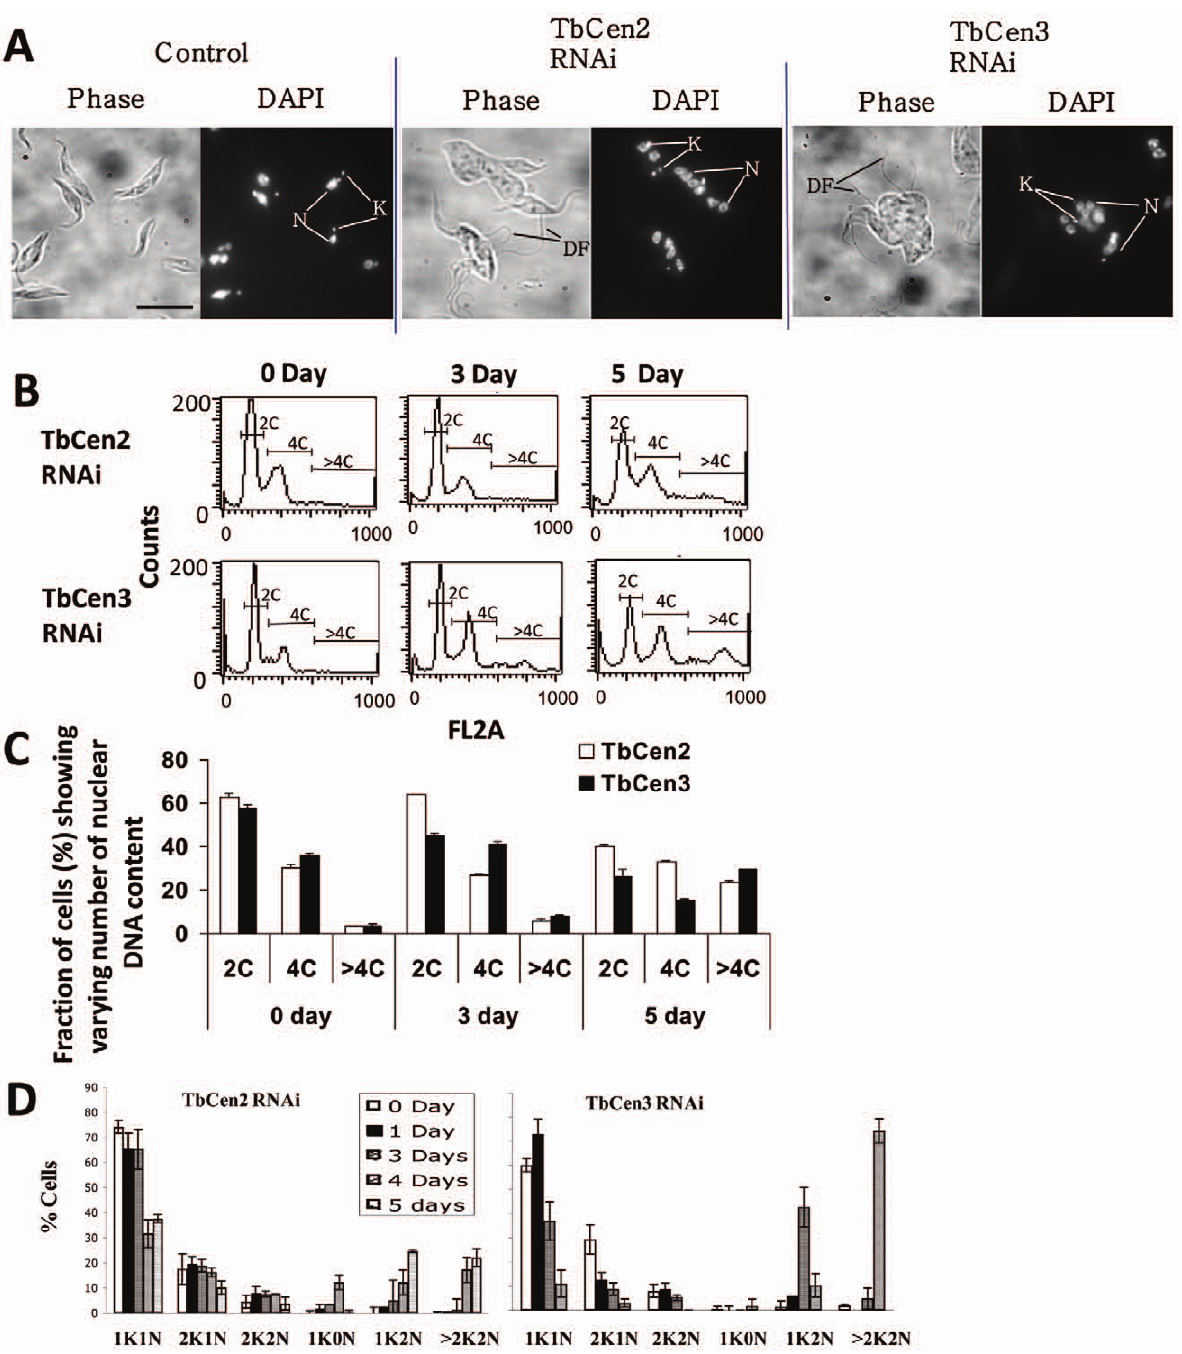
Figure 2. Analysis of cell structure and kinetoplasts and nuclei number in the RNAi cells. A : DAPI-stained images of the control and TbCen2 and 3-depleted cells, 4d after RNAi induction. DF, detached flagella; K, kinetoplast; N, nucleus. Scale bar, 5 m m. ( B & C ) Fluorescence-activated cell sorting analysis for relative DNA content of TbCen2 and 3 depleted cells. B : Histogram plots of cell count by DNA content obtained directly from the flow cytometry analysis are shown. C : The percentage of cells that contain two times the DNA content (2C), four times (4C), and more than 4 times ( . 4C) were measured at each time point and are shown. Data represent the means 6 SD of three independent experiments. D : Bar graph showing increase in the proportion of multinucleated and multikinetoplast cells with time after RNAi knockdown of TbCen2 and 3. Cells after different days of RNAi induction were stained with PI and examined by fluorescence microscope for tabulation of the cells with different number of kinetoplasts and nuclei. The time points at which the cells were analyzed after induction was up to day 5 for TbCen2 RNAi cells and day 4 for TbCen3 RNAi cells. Data represent the means 6 SD of three independent experiments. For each TbCen2 and 3 RNAi studies, over 140 cells were manually counted and analyzed.